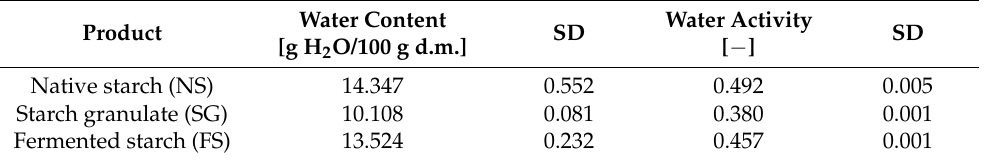
Table 2. Water content and water activity of the analyzed cassava starch samples.